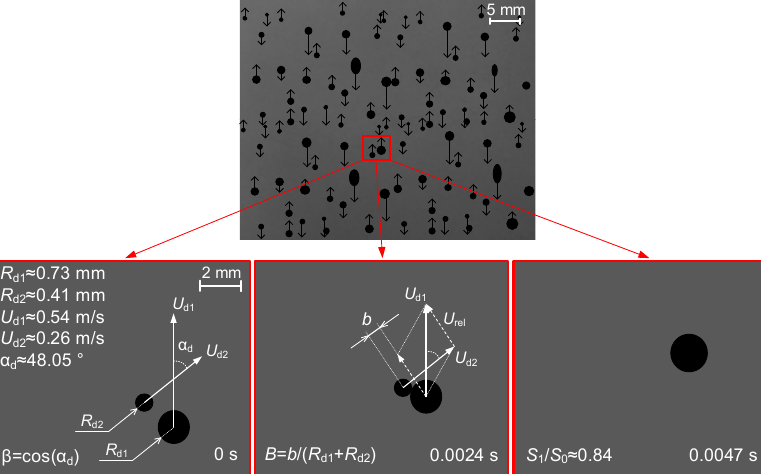
Figure 2. Recording and calculation of droplet collision parameters.